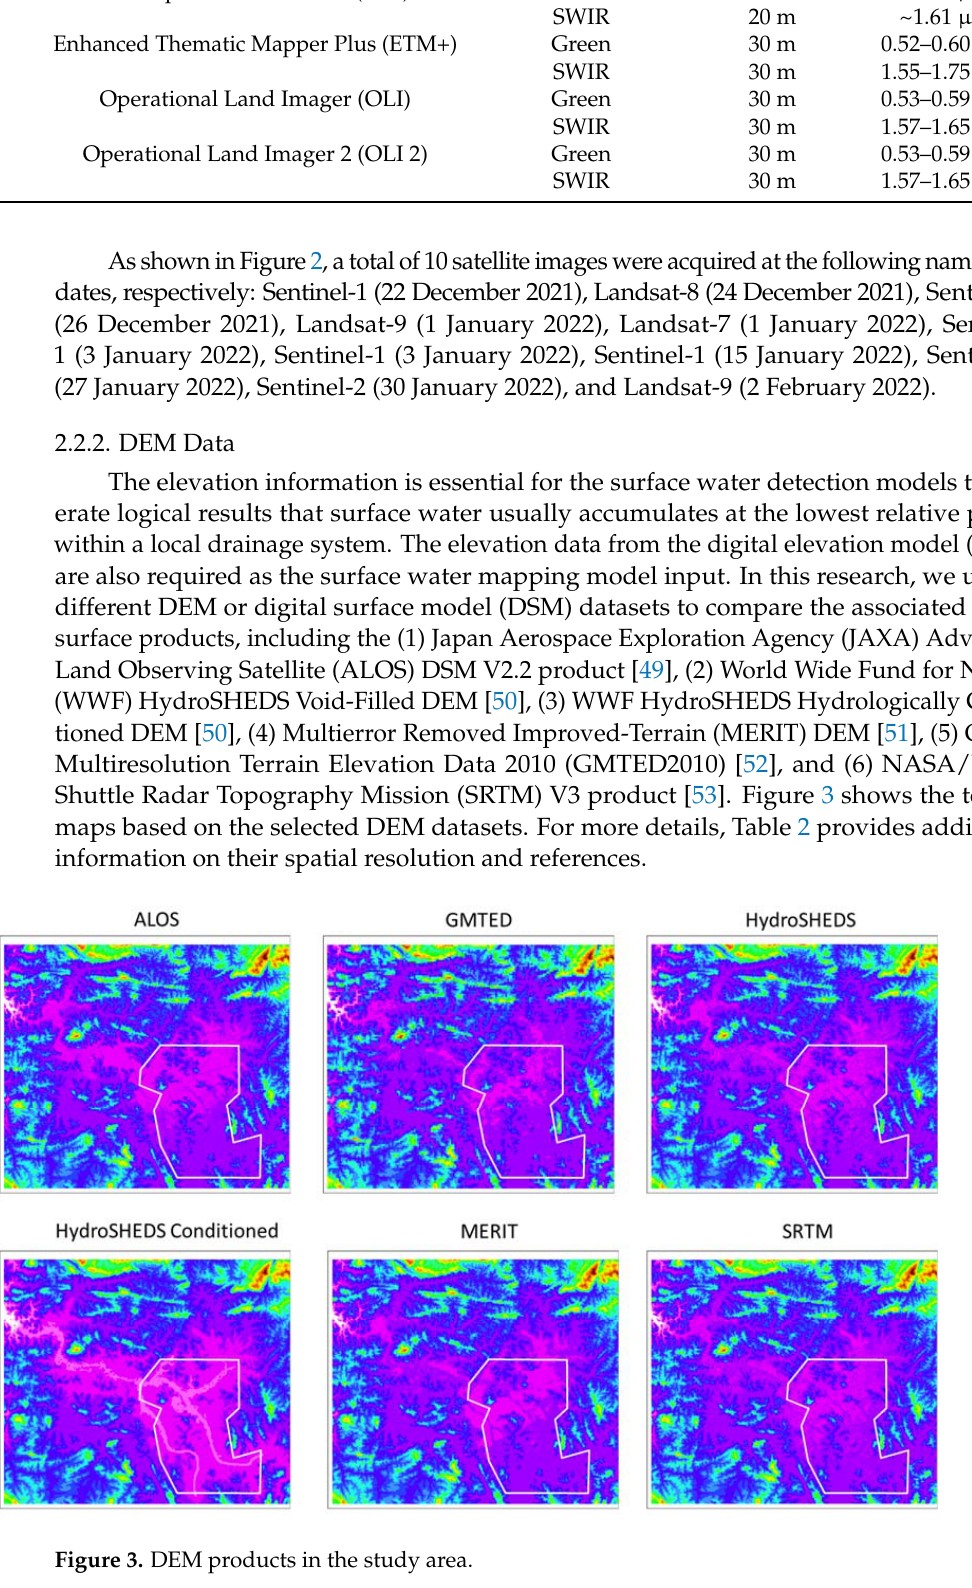
Table 1. Characters of the satellite images used in this study.